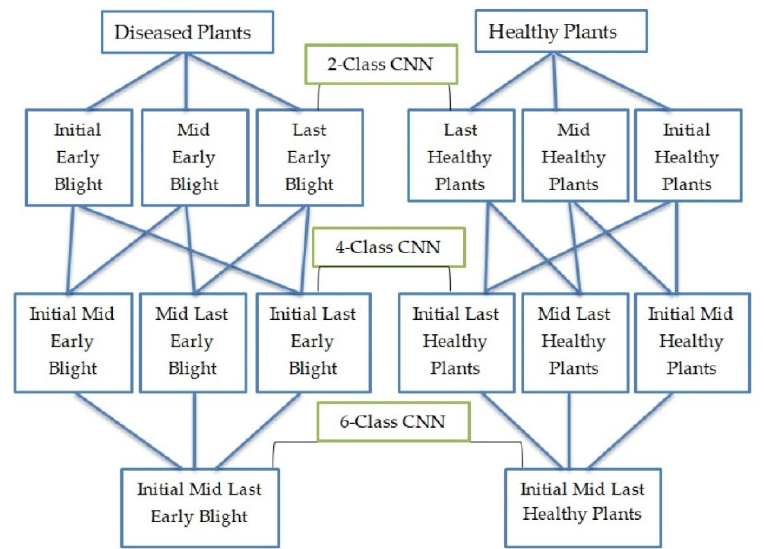
Figure 2. Concept flowchart of combinations of disease and healthy plant stages to assess and compare the classification accuracy of 2-Class, 4-Class, and 6-Class convolutional neural networks (CNNs).